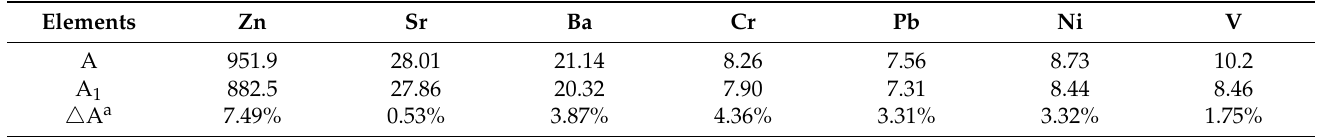
Table 4. Comparison element content changes in samples B and B 1 (ppm).